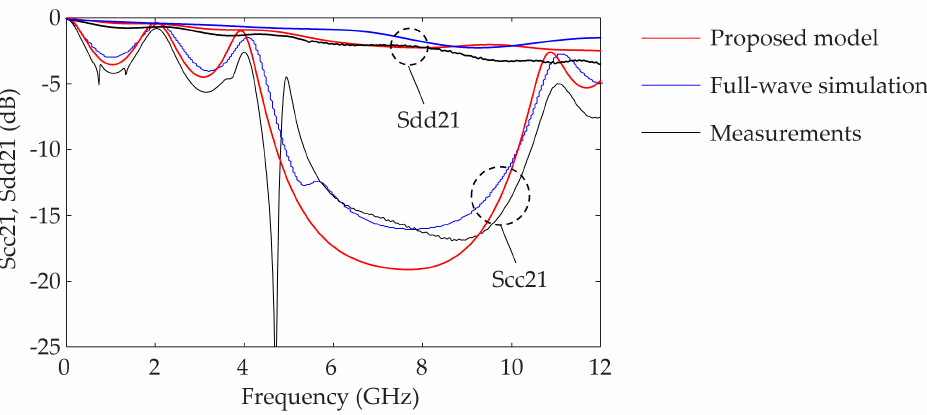
Figure 9. ( a ) Fabricated CGP-EBG MTM-DTL, and ( b ) measurement set-up for S-parameters.